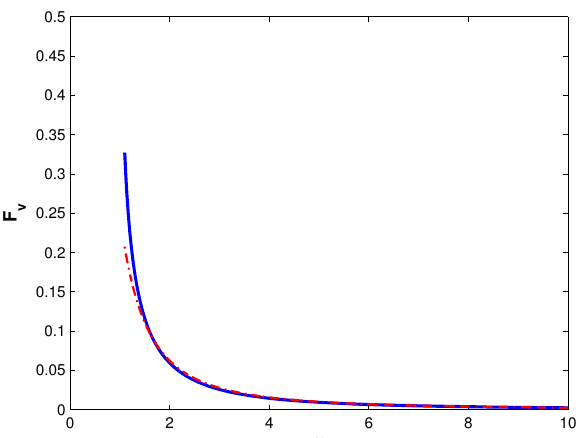
Figure 4. Variation of the dimensionless damping coefficient, F v , entering in Equation (27). The dash-dotted line describes the approximate shape of F v ( κ ) , corresponding to large distances.